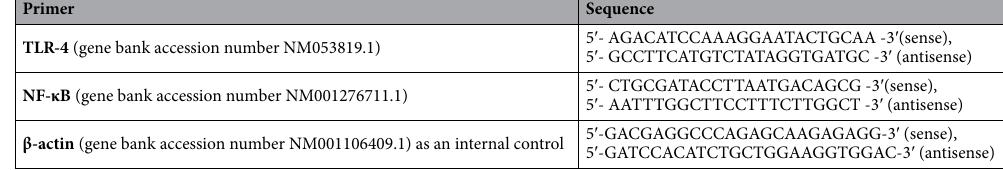
Primer Sequence TLR-4 (gene bank accession number